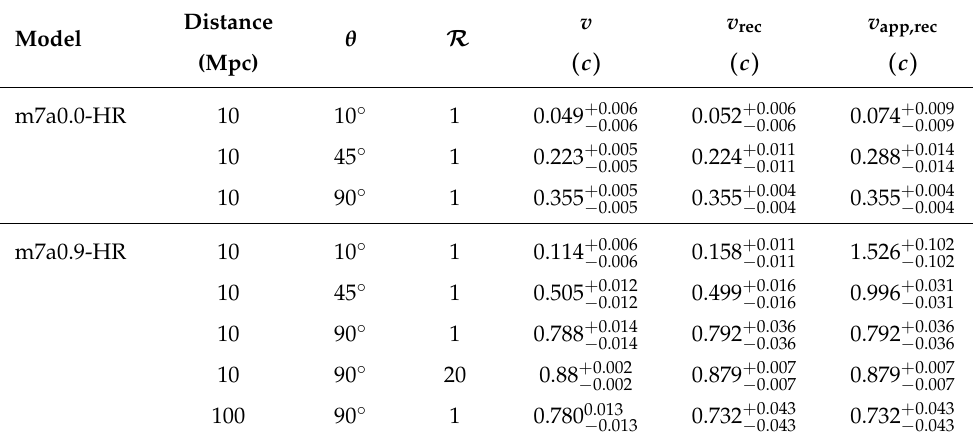
Table 4. Here we tabulate the estimated jet velocity for each model for different choices of the distance D , viewing angle θ , and plasma temperature ratio R . The velocities shown were calculated using the base ipole images ( v ), the reconstructed images ( v rec ), and the reonstructed images, while accounting for the possibility of superluminal motion ( v app,rec